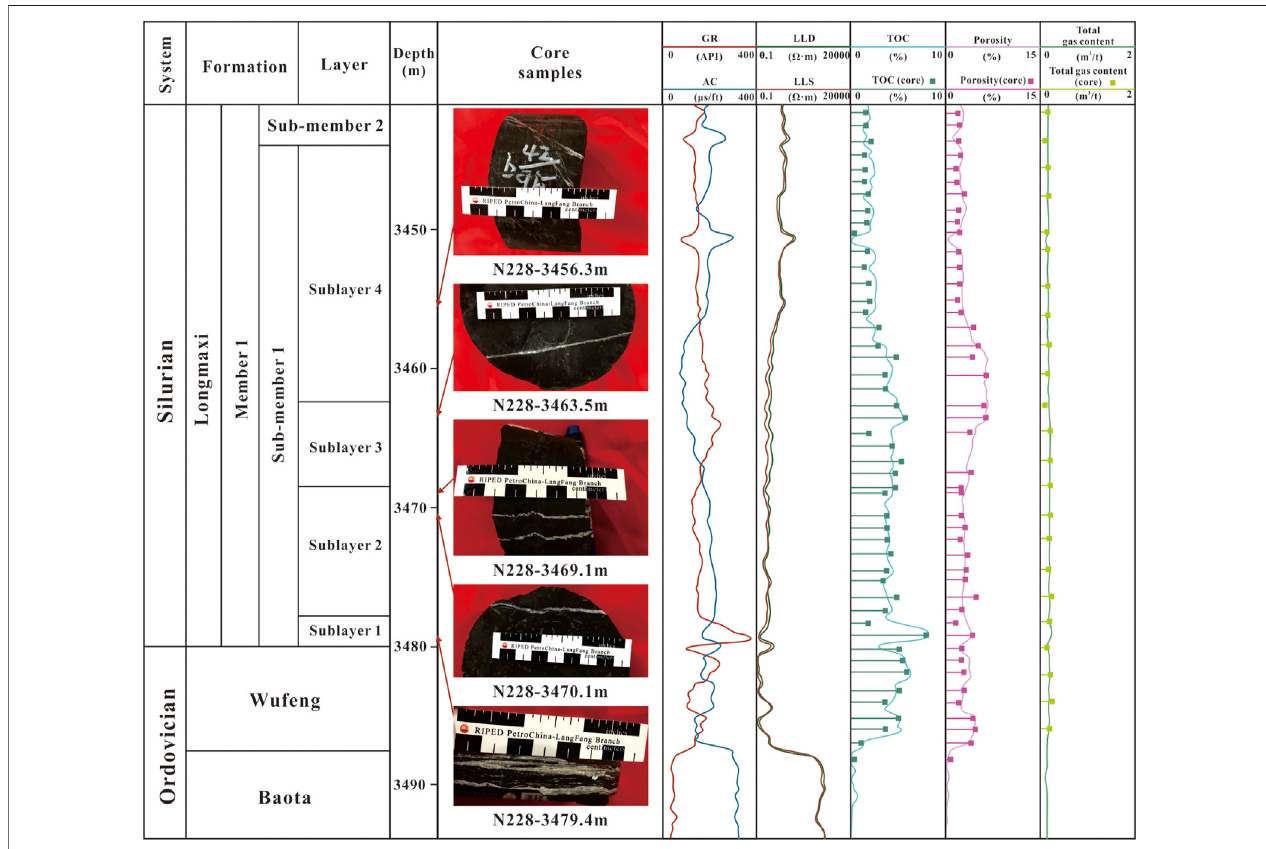
FIGURE2| Stratigraphic columnar diagramofwell N228 intheChangningarea,southernSichuanBasin, withsamplespositions, resistivitylogs, TOCdistribution, porosity, and total gas content distribution.